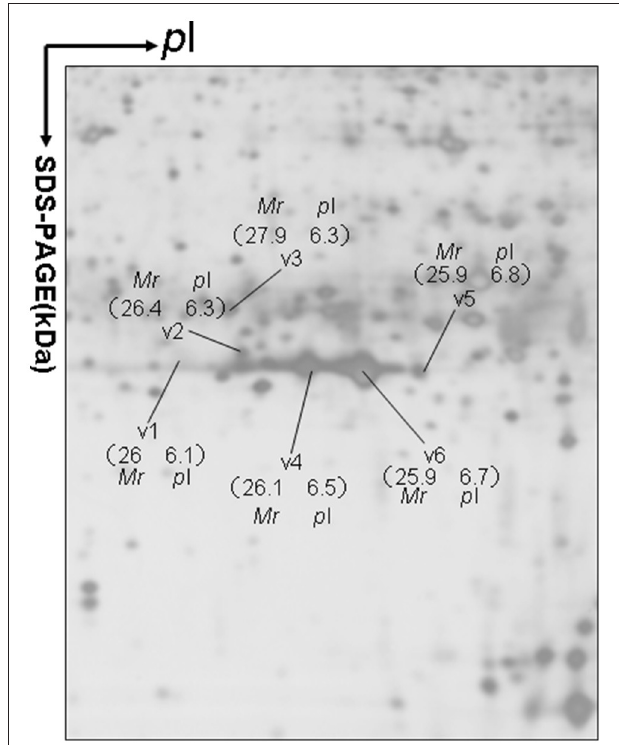
FIGURE 1 | A representative 2DGE image (master gel image from a control) between a comparison between 8 control tissues and 16 human pituitary adenoma tissues. IEF was done with an 18-cm IPG strip (pH 3–10, nonlinear), and vertical SDS-PAGE was done with a 12% polyacrylamide